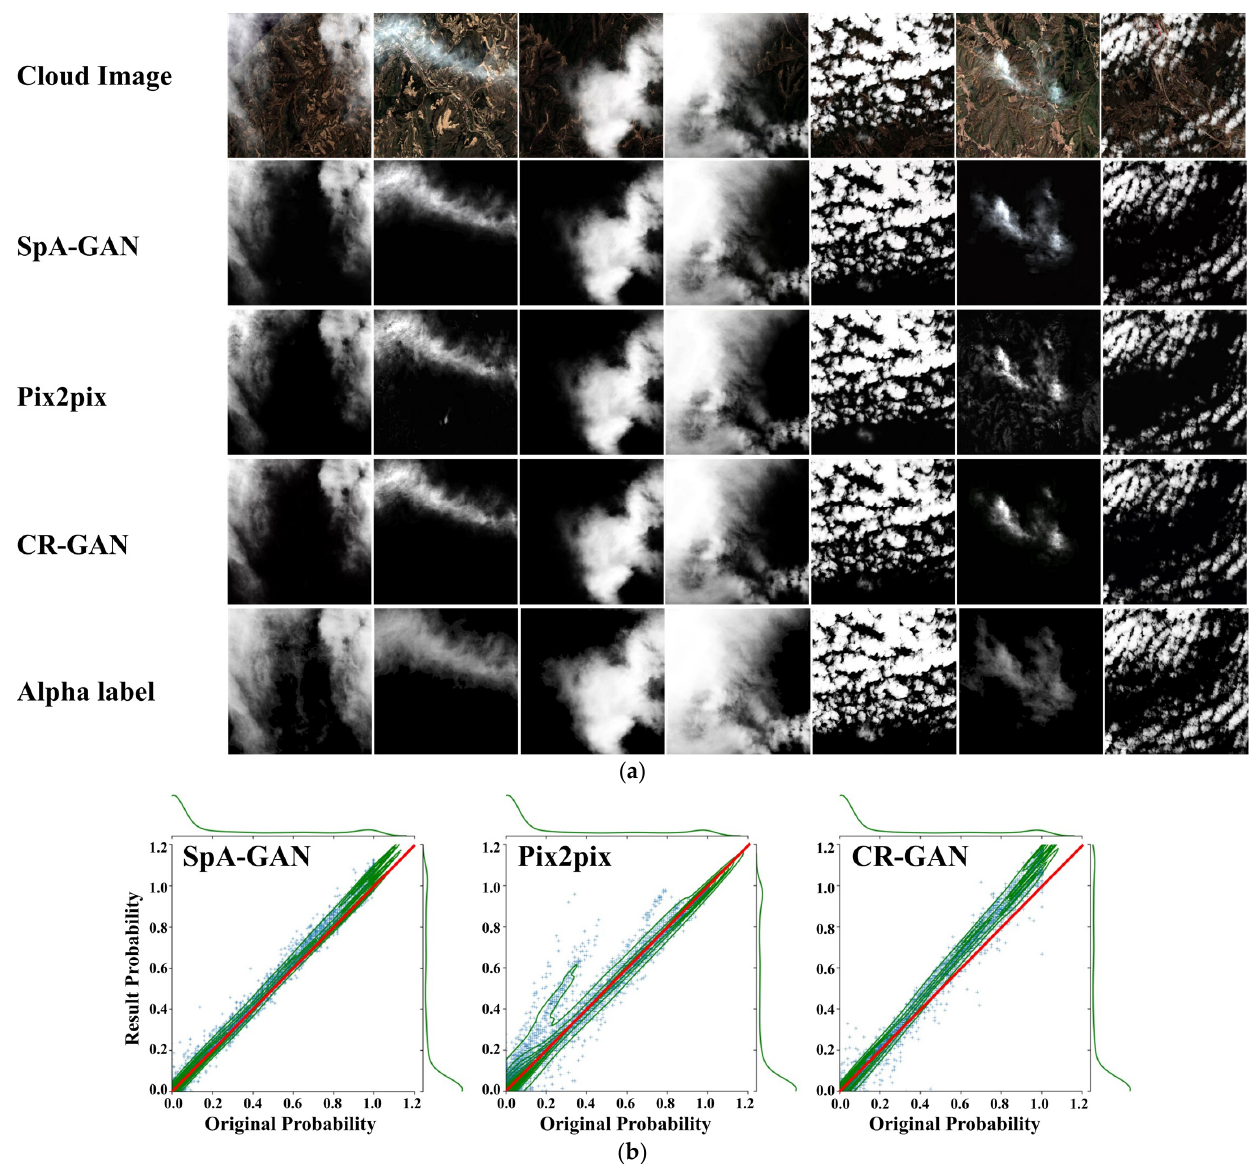
Figure A4. ( a ) Results of cloud opacity estimation of CGANs after changing the conditions, and the elements in Figure are consistent with Figure A3(a). ( b ) Cloud opacity estimation results compared to actual values for various cloud removal methods. One hundred thousand points are randomly sampled from the opacity estimation results, and their distributions are counted. The red line in the Figure represents the optimal estimate, and the closer the data distribution is to the line the more reliable the cloud removal results are. The green curve represents the probability density of the scattered points.